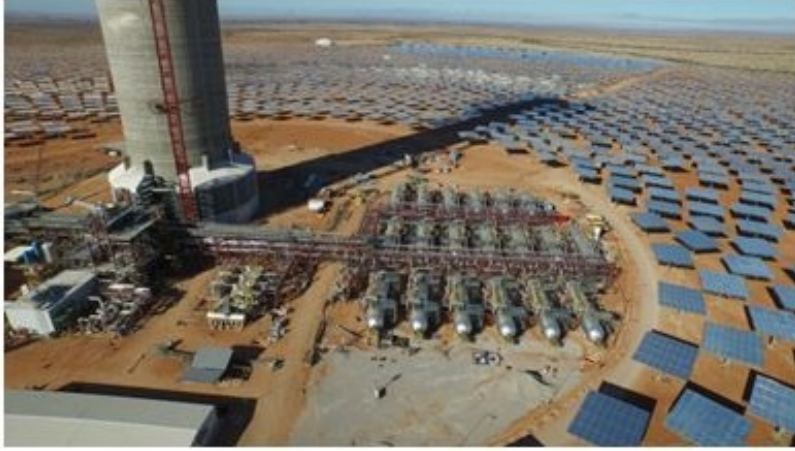
Figure 3. Steam accumulators of 50 MWe Khi Solar One plant (Source: Abengoa).